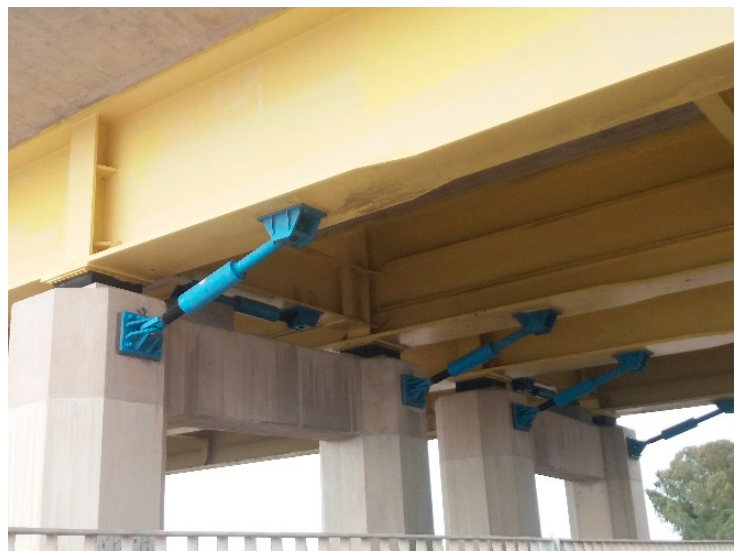
Figure 1. Supplemental viscous dampers installed in conjunction with elastomeric bearings in Rion-Antirion bridge, Greece.